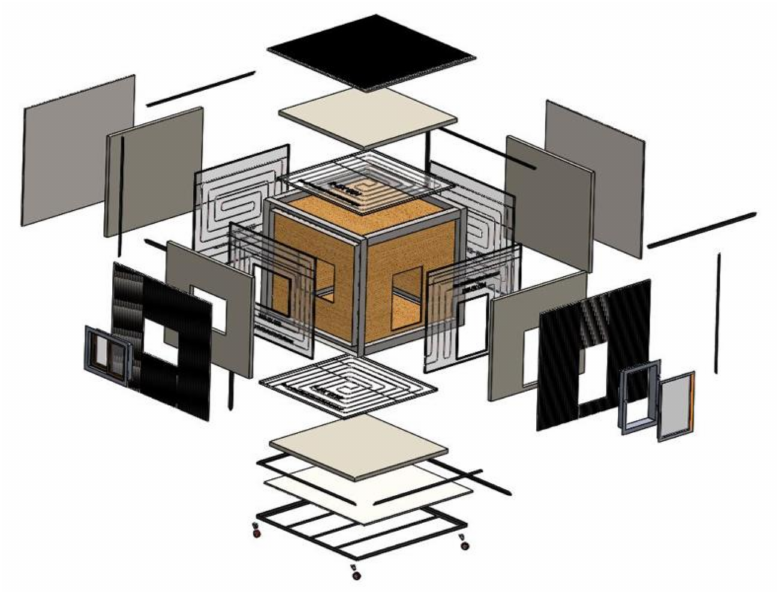
Figure 28. Thermally activated building structure (TABS) applied within the prototype using radiant pipes embedded in PCM